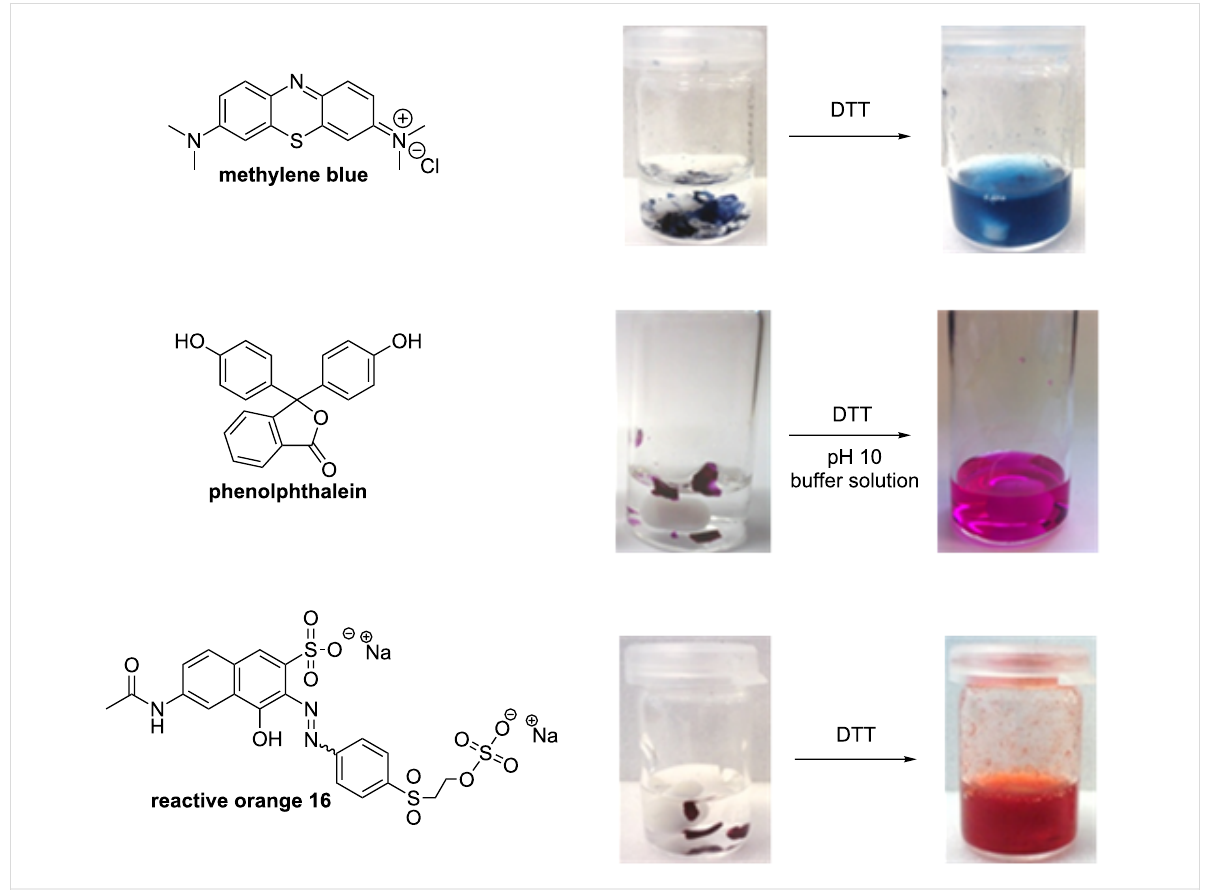
Figure 1: Release of enclosed dyes from polycationic networks containing disulfide bonds after treatment with